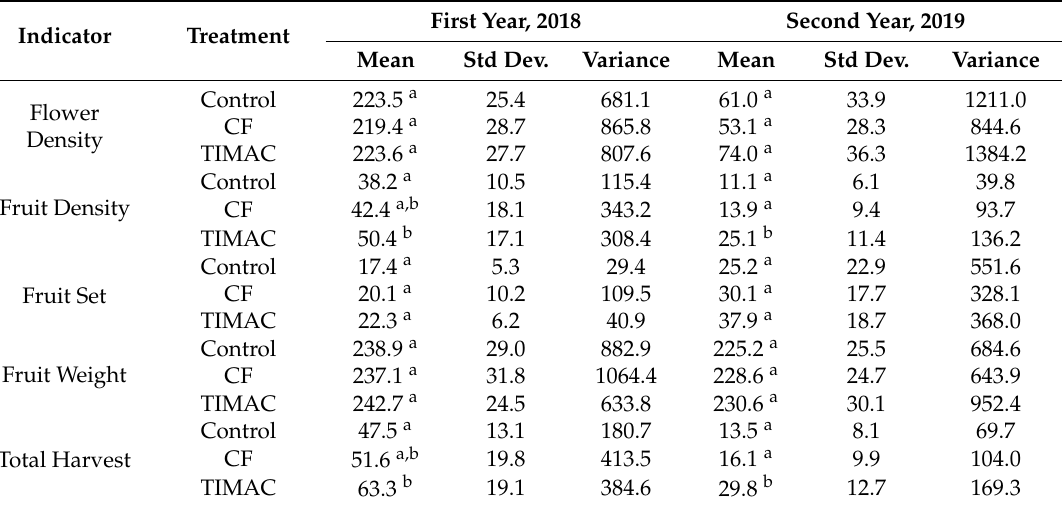
Table 5. Statistical results of selected